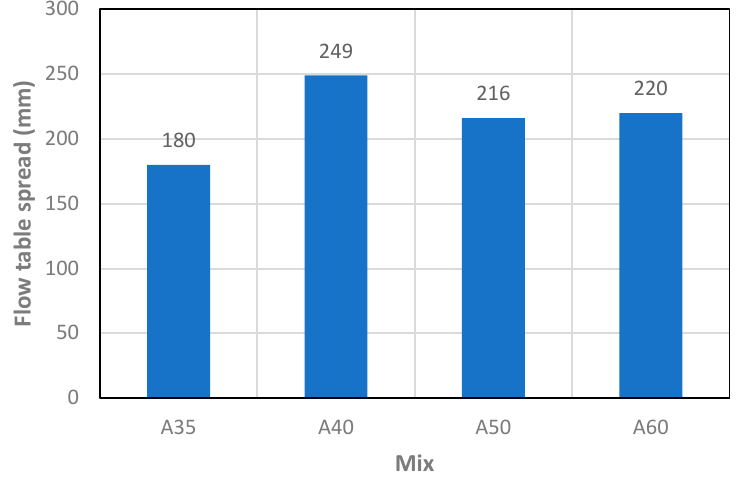
Figure 5. Matrix workability obtained from flow table test.